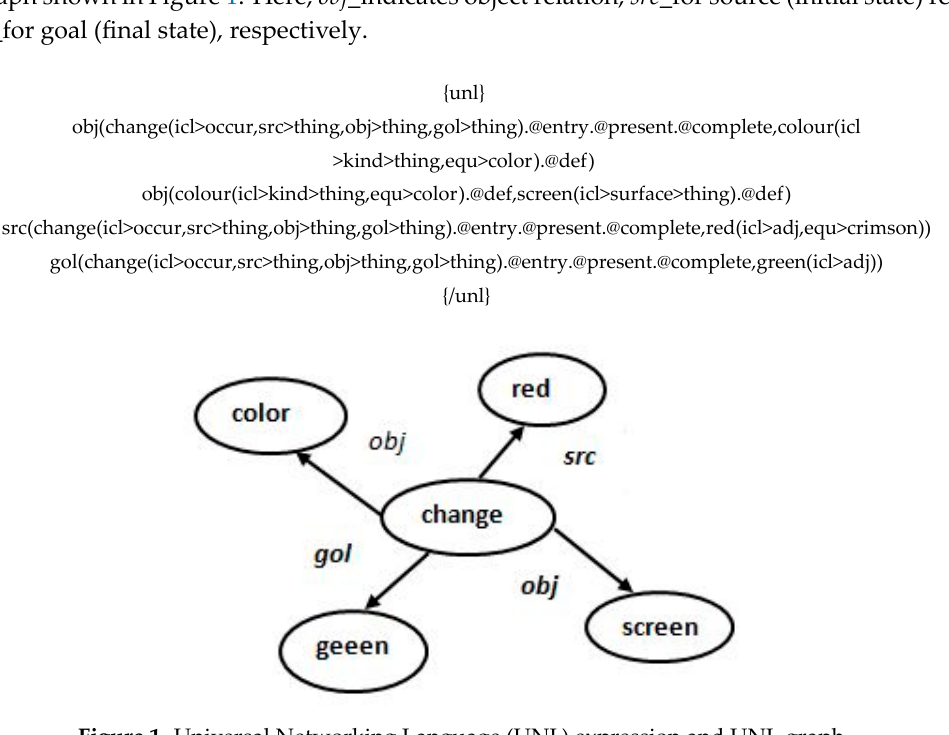
Figure 1. Universal Networking Language (UNL) expression and UNL graph.